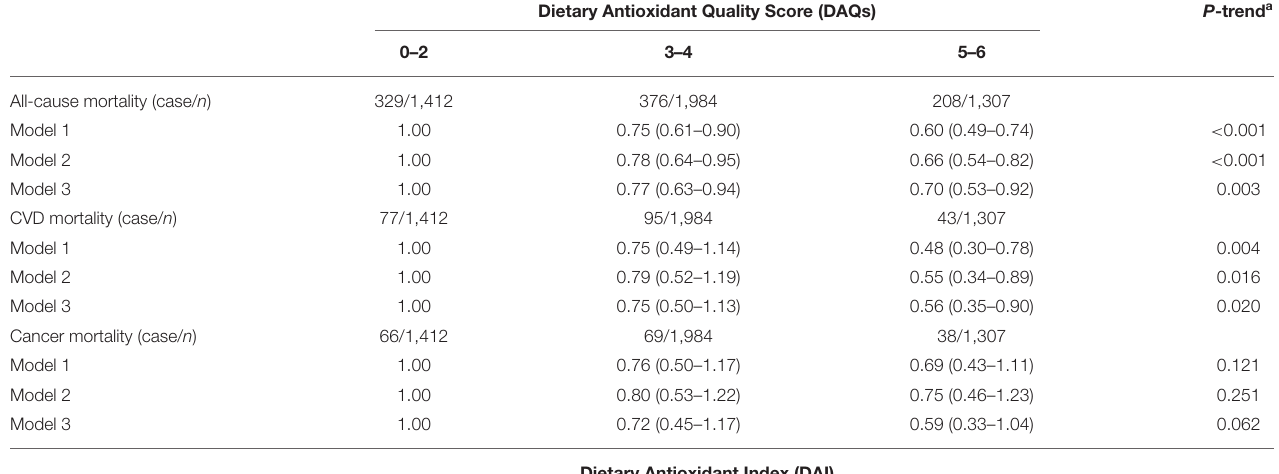
TABLE 2 | Association of the Dietary Antioxidant Quality Score (DAQS) and the Dietary Antioxidant Index (DAI) with all-cause and cause-specific mortality among adults with diabetes in the National Health and Nutrition Examination Survey (2003–2014). Dietary Antioxidant Quality Score